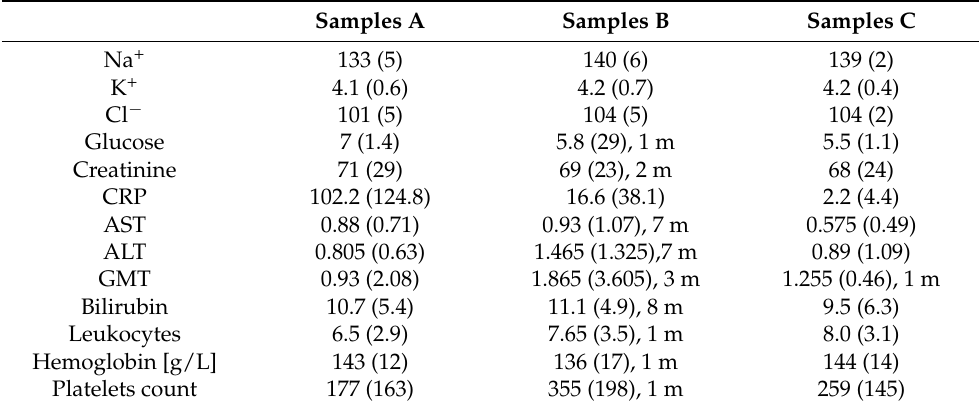
Table 2. Standard biochemical and hematological results of patients at the sampling times, median (interquartile range), m indicates the number of missing